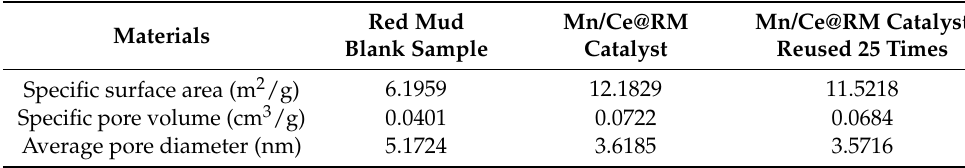
Figure 2. SEM characterization results: ( a ) Red mud blank sample; ( b ) Mn/Ce@RM catalyst (Fly ash floating beads); ( c ) Mn/Ce@RM catalyst reused 25 times. Table 2. Pore structure characteristics of different